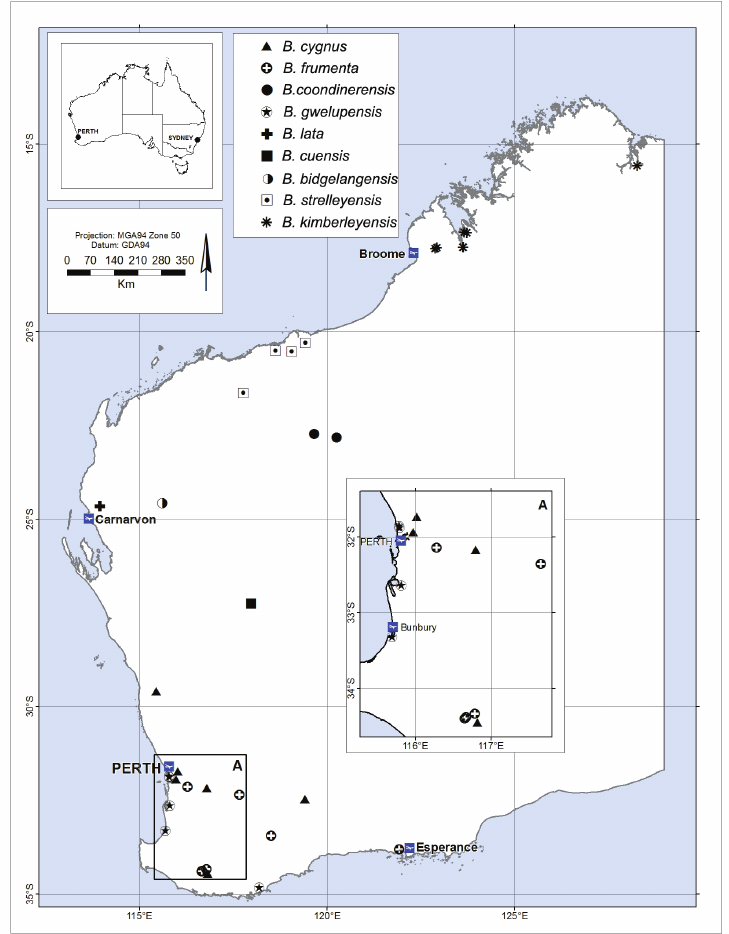
Fig. 1. Map of Western Australia with localities of Bennelongia - species described in the present